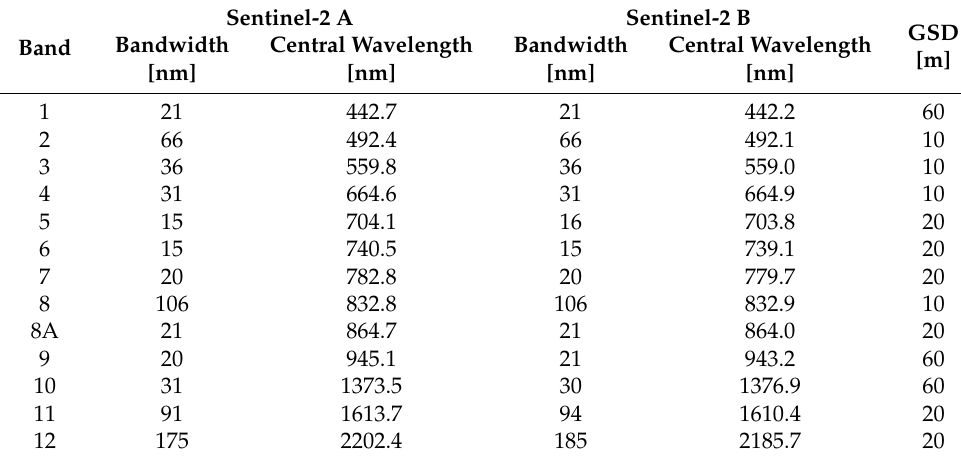
Table 1. Bands characteristics of Sentinel-2 multispectral